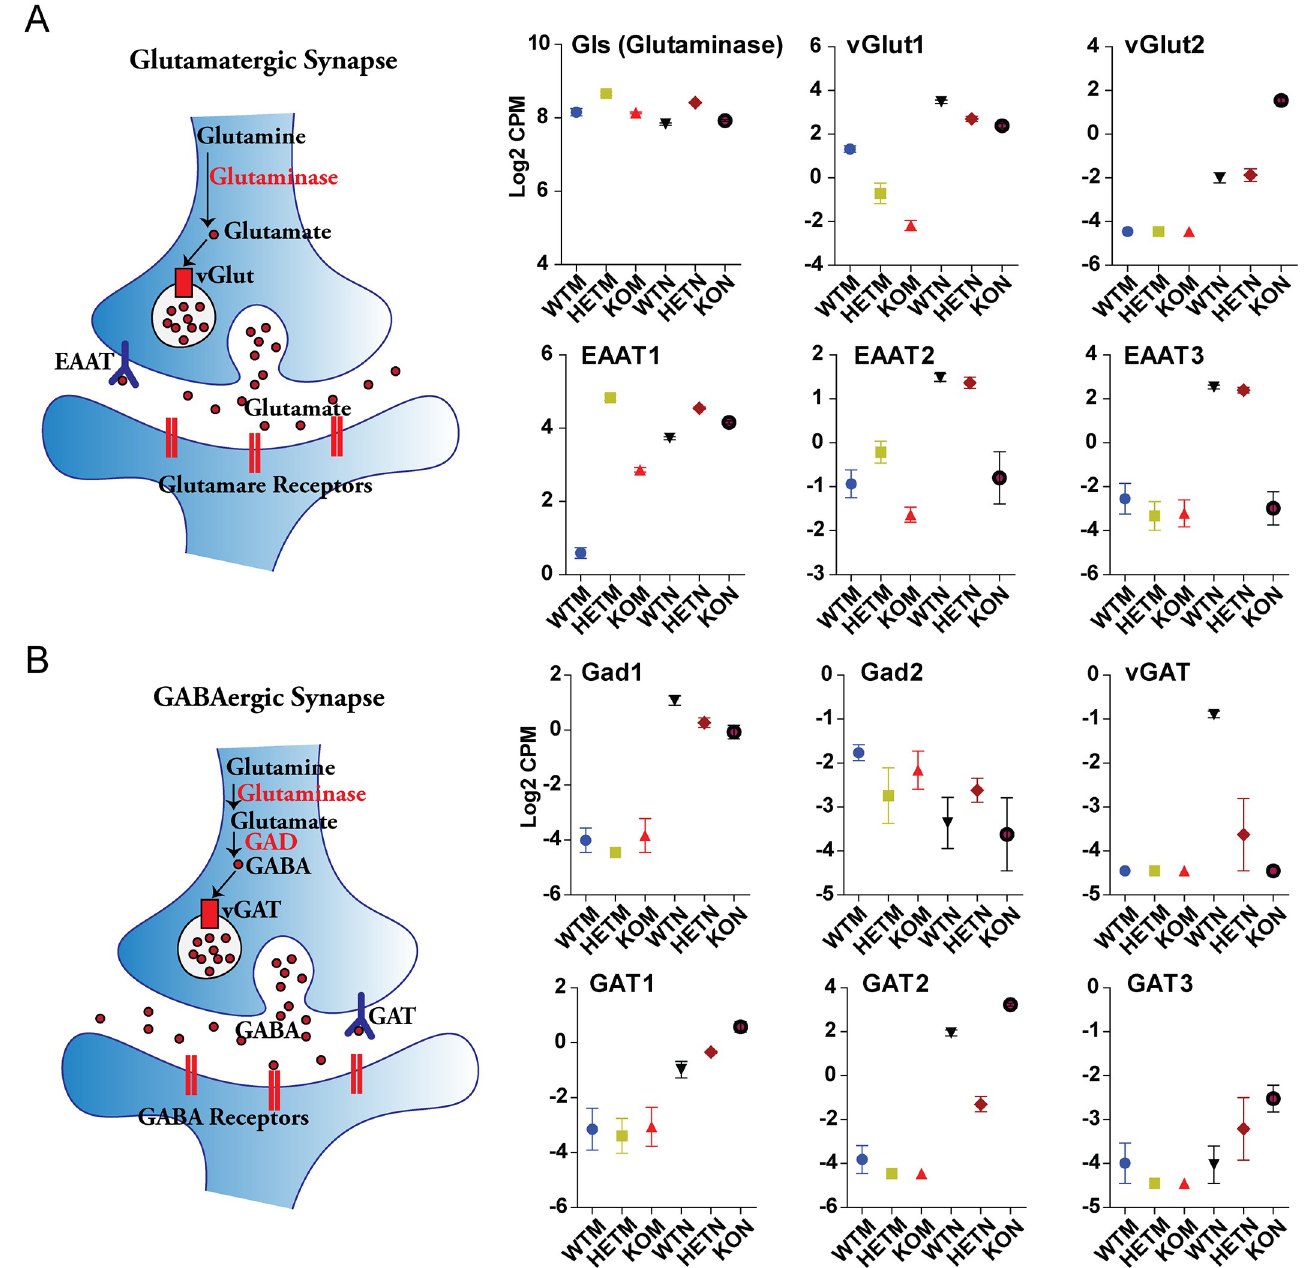
Fig 5. β -actin differentially affects the expression of excitatory and inhibitory neuron markers. (A) The schematics of key genes and processes in Glutamatergic synapse (Excitatory). The relative expressions of Glutaminase ( Gls ), vGlut1 , vGlut2 , EAAT1 , EAAT2 and EAAT3 are shown. (B) The schematics of key genes and processes in GABAergic synapse (inhibitory). The relative expressions of Gad1 , Gad2 , vGAT , GAT1 , GAT2 and GAT3 are shown. The plots are the summary of at least 3 biological replicates from RNA-seq analysis. Error bar: S.E.M.